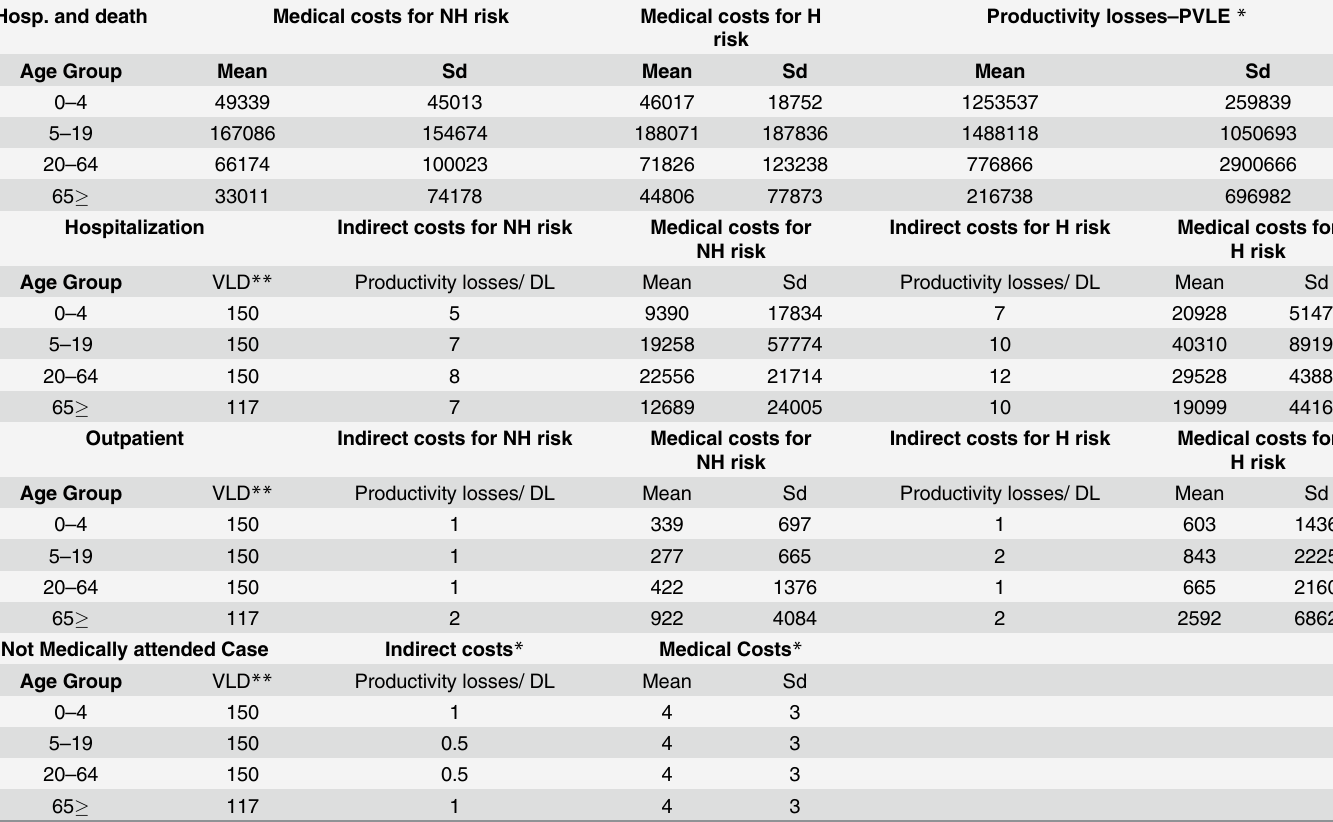
Table 2. Cost of Influenza